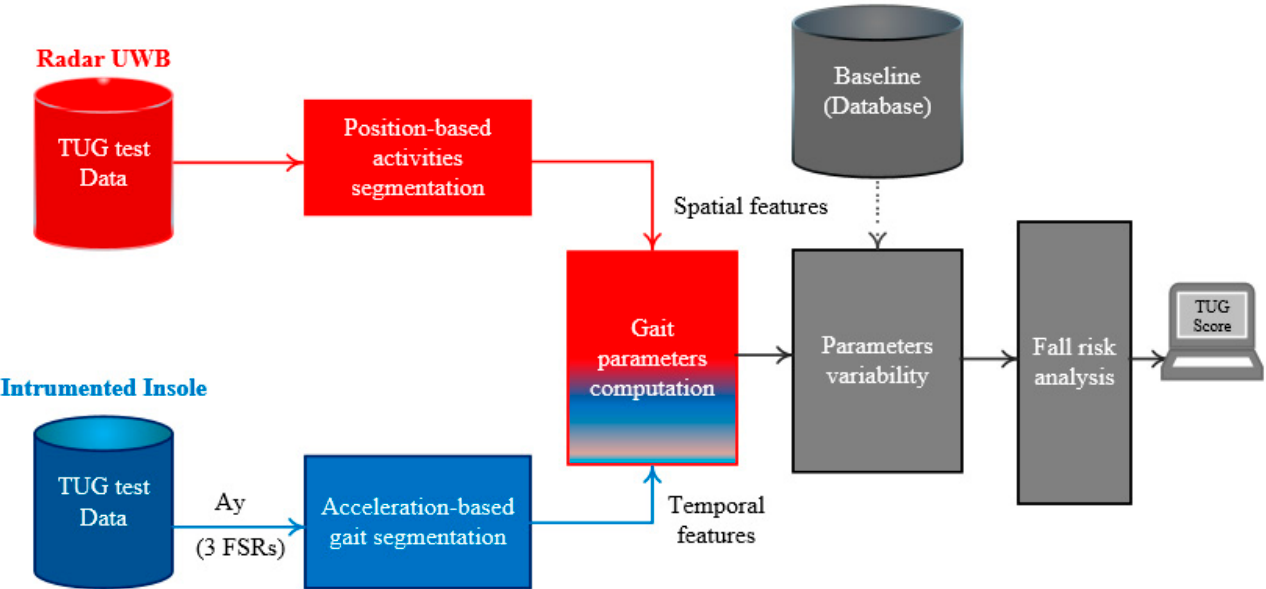
Figure 3. Computational flow of the proposed method for evaluating a risk of falling in home settings using a TUG test. (Ay: the y-axis of the three-dimensional (3D)-acceleration; TUG: Timed Up and Go).